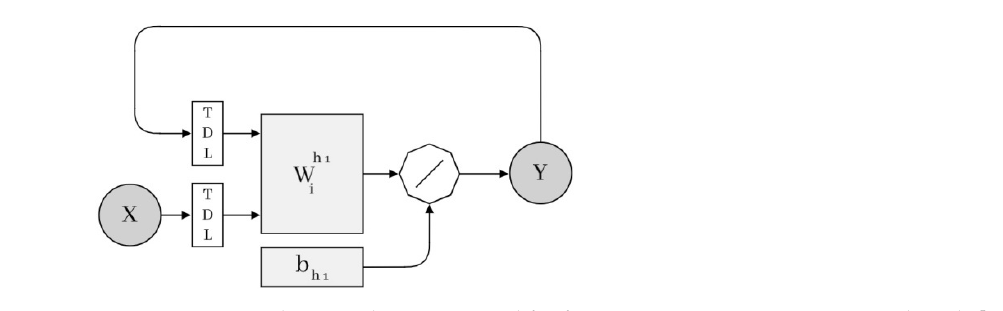
Figure 5. A general NARX diagram is used for forecasting purposes in operational mode [23].